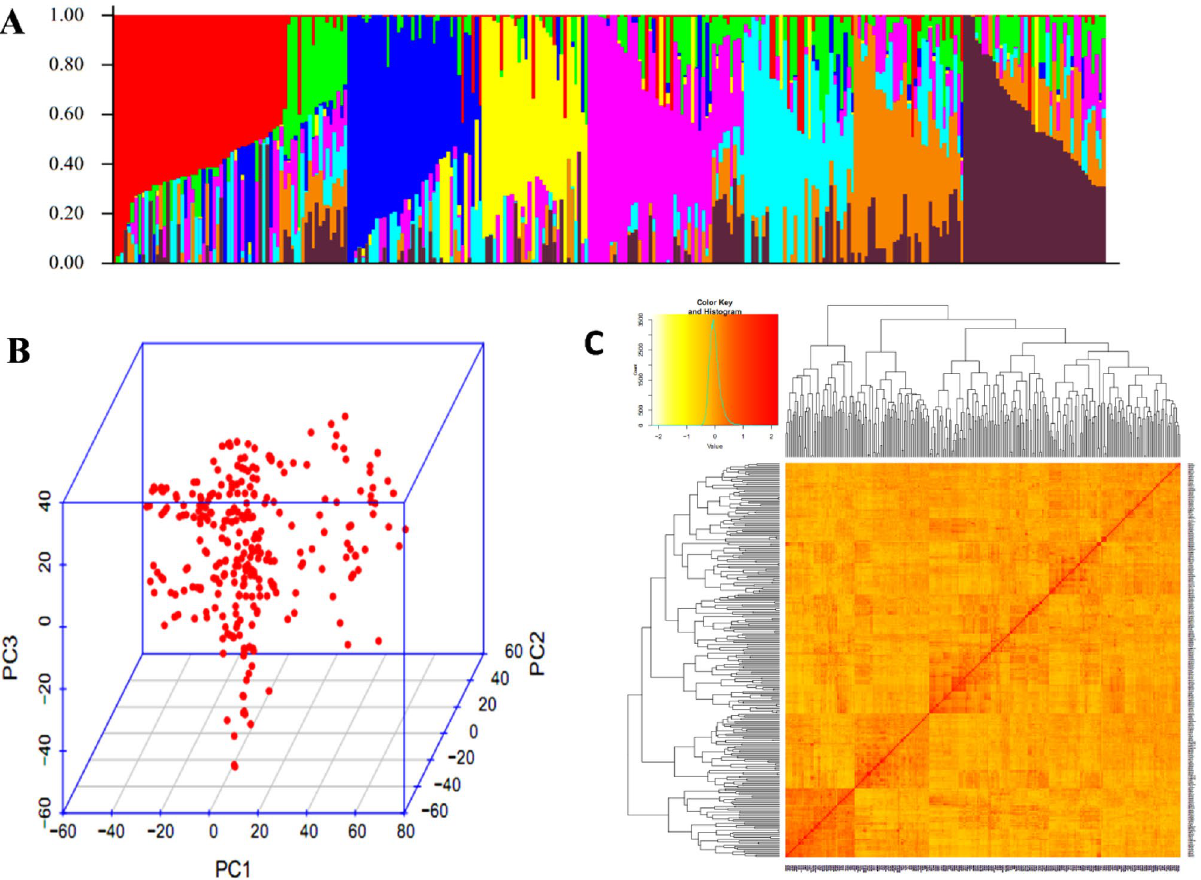
Figure 2. Population groupings in GWAS panel from different models. ( A ) Population structure based on STRU CTU RE ( B ) Three-dimensional plot of the first three principal components, and ( C ) heat map of pair- wise kinship